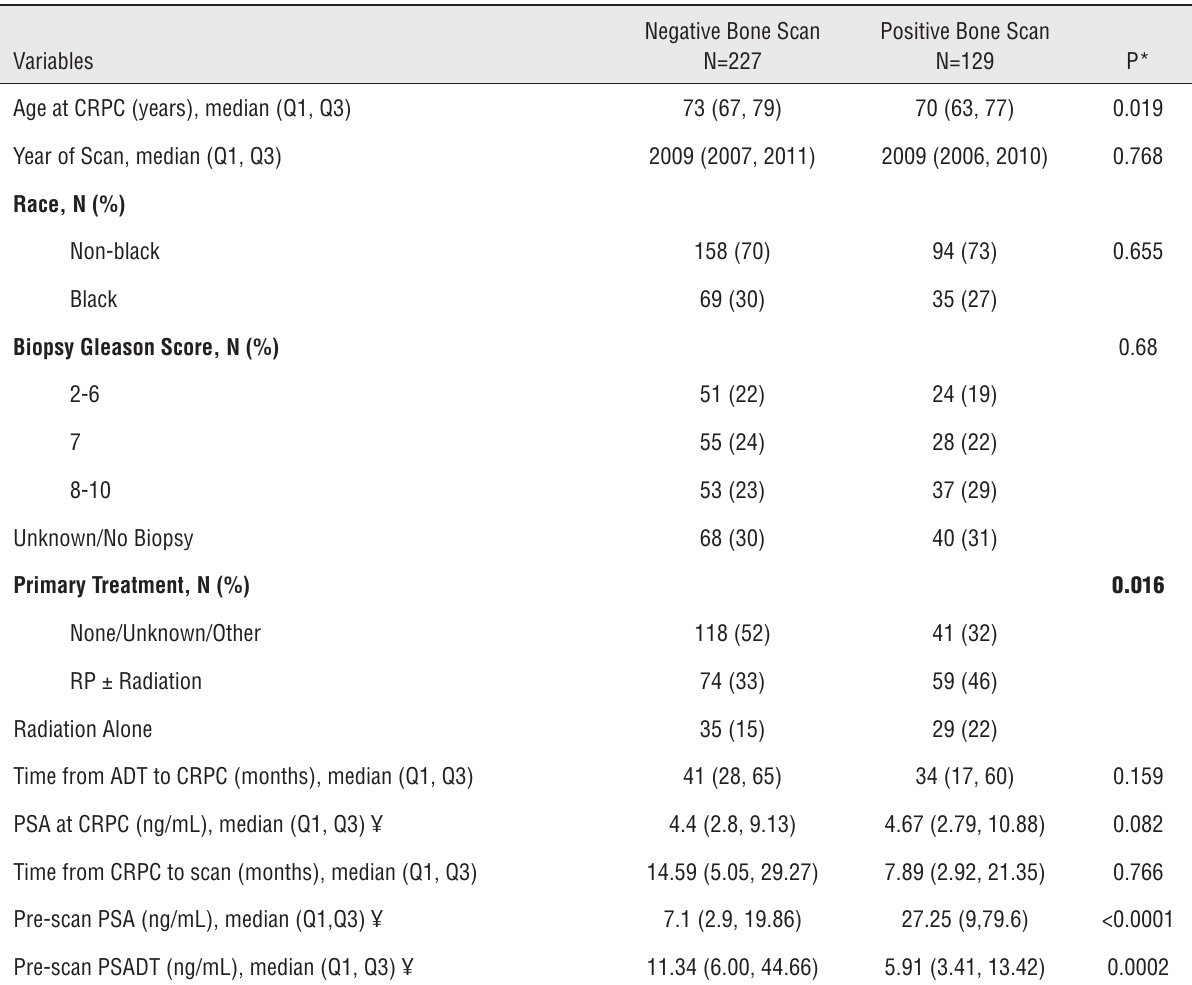
Table 2 - Baseline Patient